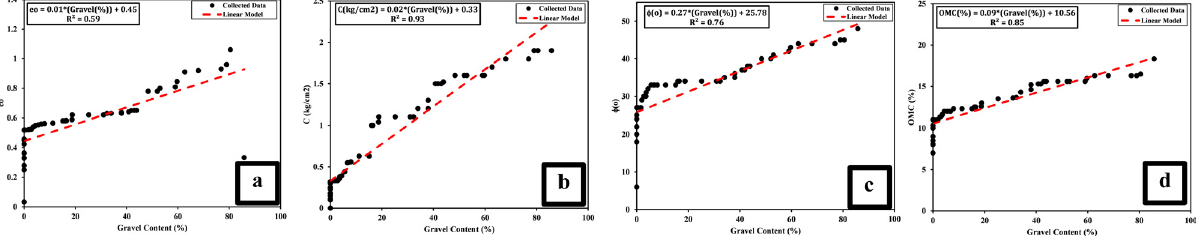
Figure 6: The variation in various soil characteristics vs gravel content for Kirkuk city: ( a ) e o vs gravel content ( % ) , ( b ) c ( kg/cm 2 ) vs gravel content ( % ) , ( c ) ϕ vs gravel content ( % ) , and ( d ) OMC ( % ) vs gravel content ( % )